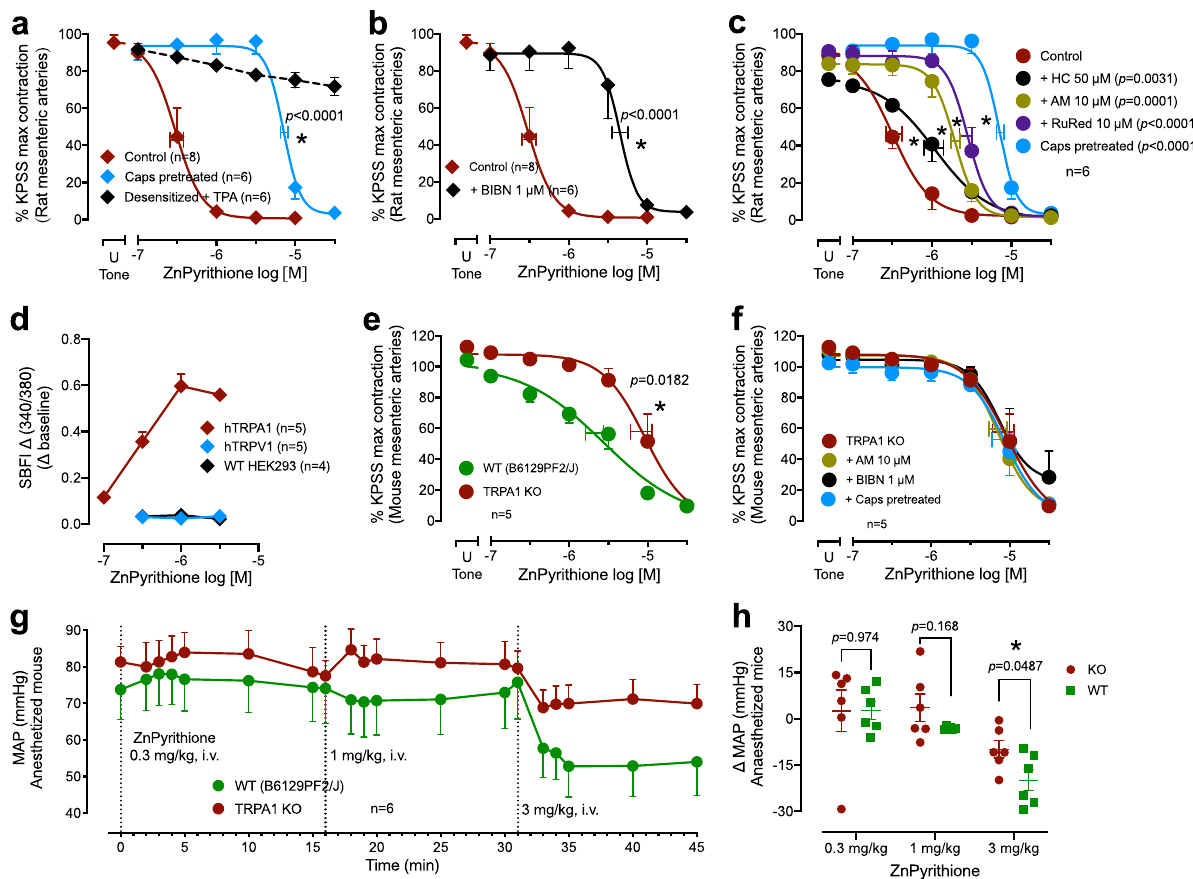
Fig. 4 Impact of perivascular sensory nerves on zinc ionophore-dependent vasorelaxation in rats and TRPA1 KO mice. a – c Effects of zinc pyrithione with/without perivascular sensory nerve desensitization by capsaicin (caps pretreated), or concomitant zinc chelation with TPA ( a ), the CGRP receptor antagonist BIBN4096 (BIBN, b ), or the TRPA1 channel blockers ruthenium red (RuRed), AM0902 (AM) or HC030031(HC) ( c ). d Zinc pyrithione activates hTRPA1 expressed in HEK293 cells (measured by the Na + selective intracellular dye SBFI-AM), but not hTRPV1 or non-transfected (WT) HEK293 cells. e Decreased relaxation potency of zinc pyrithione in isolated mesenteric arteries from TRPA1 KO mice compared to WT mice. f Capsaicin desensitization, BIBN4096 or AM0902 did not affect the relaxation potency of zinc pyrithione in TRPA1 KO mice. g , h Mean arterial pressure (MAP) after an intravenous (i.v.) bolus injections of 0.3, 1, and 3 mg/kg zinc pyrithione ( g ) and the peak change in MAP ( h ) in WT (B6129PF2/J) mice. Arteries in a – c , e , and f were contracted with U46619 (U Tone) and responses are expressed as a % of the KPSS (124 mM K + )-evoked contractions (Supplementary Table 3). Error bars are SEM (those not shown are contained within the symbol); horizontal error bars are for the average EC 50 . n , number of rats, mice or arteries isolated from separate animals. The control curve in ( a ) and the TRPA1 KO curve in ( e ) are shown again in ( b ) and ( f ), respectively for representation. *Statistically signi fi cant, 1-way ANOVA of EC 50 [ F (9,61) = 27.60, p < 0.0001 in ( a , b ) and F (3,20) = 15.15, p < 0.0001 in ( c )] followed by Dunnett ’ s post-test vs. control; F (3,19) = 0.0538, p = 0.983 in ( d ); two-tailed unpaired Student ’ s t test [T(9) = 2.879 in ( e ) and T(10) = 2.444 in ( h